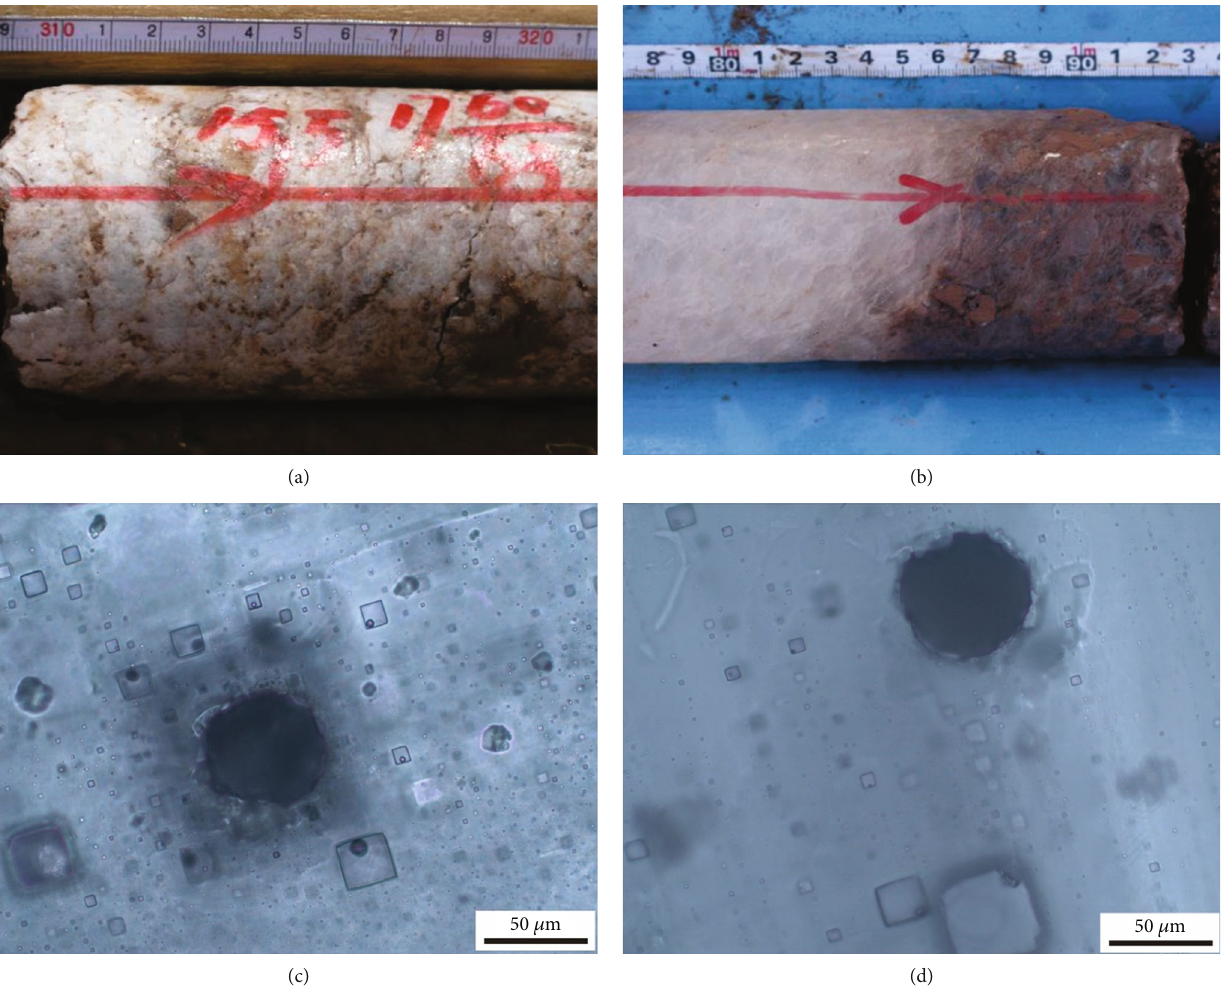
Figure 3: Characteristics of evaporite lithology and halite fl uid inclusions from borehole DZK01 in the Kuqa Basin. (a) Gypsum rock with maroon boulder clay; (b) pure rock salt and rock salt with maroon boulder clay; (c, d) primary band-like fl uid inclusions developed along growth faces of halite crystals and pits left on the surface of halite after laser ablation.